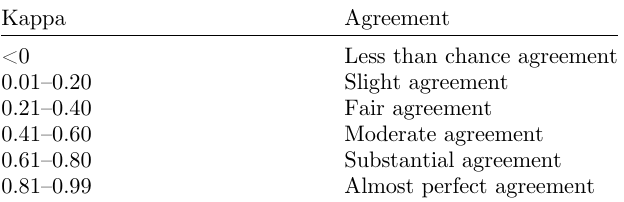
Table 7. Voting procedure: measuring sensitivity, speci fi city, and Cohen ’ s Kappa statistic ( k -Cohen)